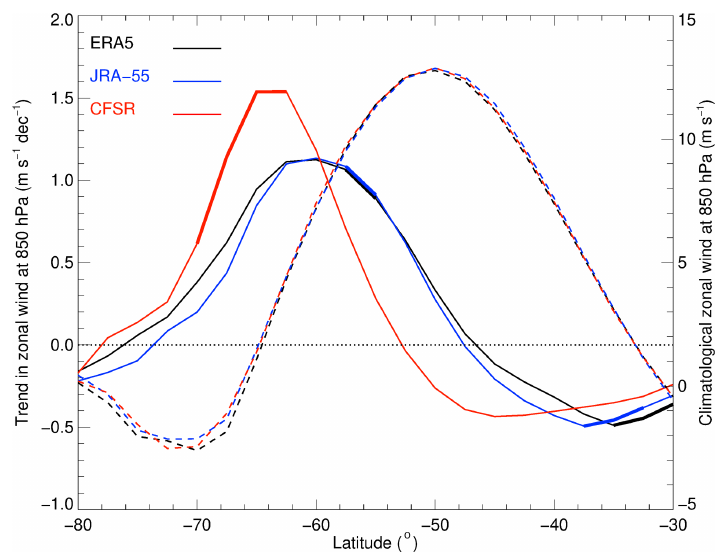
Figure A2. As Fig. 3 but showing the DJF trend (solid lines) and mean (dashed lines) in zonally averaged 850hPa zonal wind from 1980 to 2001 for ERA5 (black), JRA-55 (blue), and CFSR (red). Thick solid lines denote latitudes where the trends are significant at the 5% significance level. Note that results for MERRA-2 at this pressure level were not